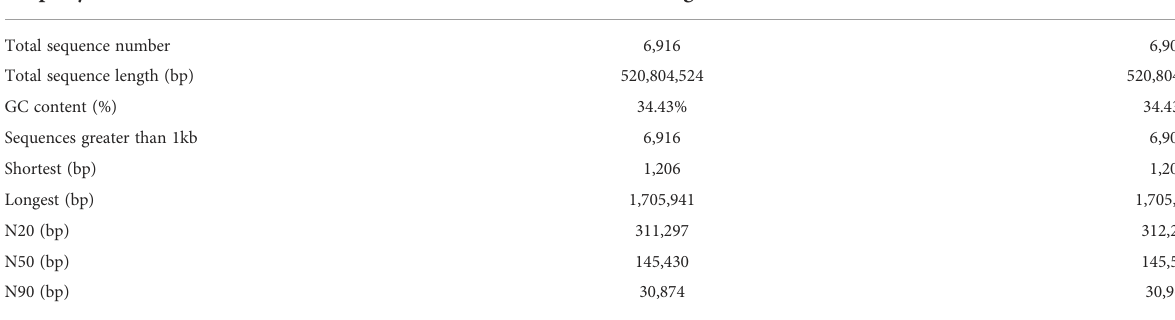
TABLE 1 Statistics of J. sambac cultivar JSDB genome